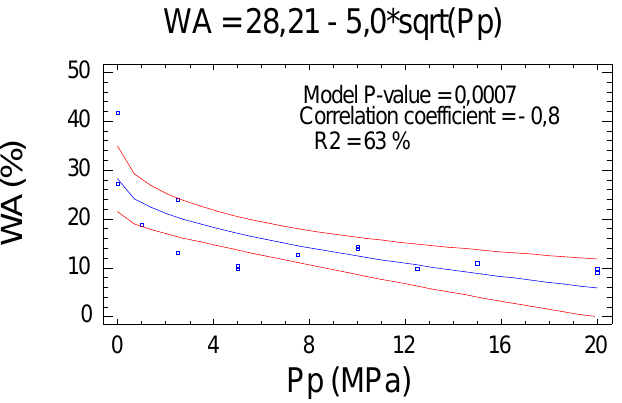
Figure 7. Influence of Pp the water absorption (WA) in function of Pp.